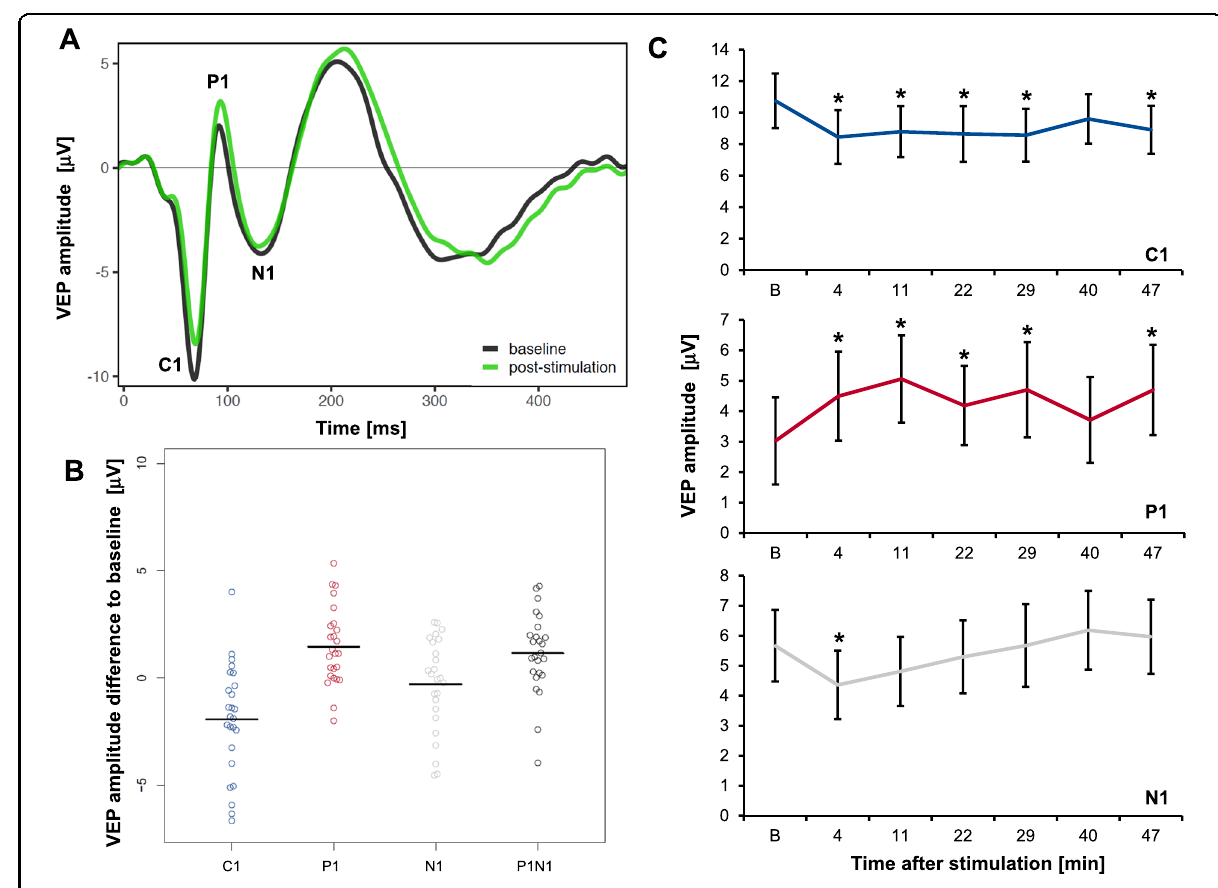
Fig. 4 tDCS-induced VEP plasticity ( n = 25, PVS − /tDCS + ). A Checkerboard reversal VEP traces before (black) and averaged poststimulation VEPs (green) after 10 min of occipital anodal tDCS. B Change in peak VEP amplitudes averaged after stimulation compared to baseline (horizontal line, mean). C1 decreased and P1 and P1N1 increased signi fi cantly. C Mean peak amplitudes of C1, P1, and N1 VEP components over time + / − SE. Asterisk indicates signi fi cant post hoc contrast of baseline peak amplitude [B] compared to test peak amplitude. VEP visually evoked potential, PVS prolonged visual stimulation, tDCS transcranial direct current